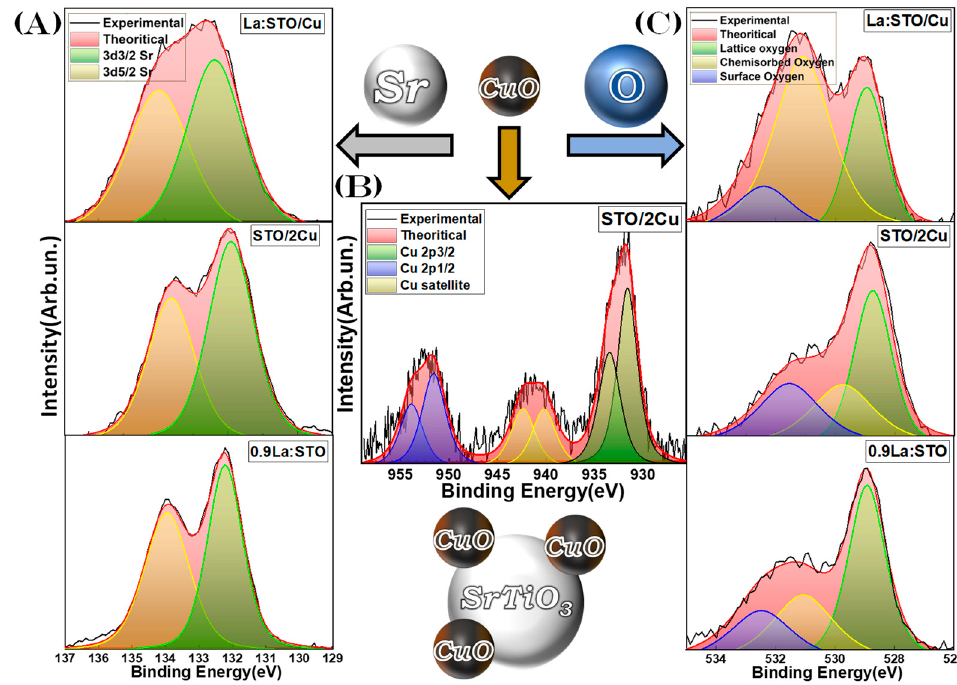
Figure 6. ( A ) Sr 3d 5/2 and Sr 3d 3/2 XPS spectra for 0.9La:STO, STO/2Cu, and La:STO/Cu materials. ( B ) Cu 2p 3/2 and Cu 2p 1/2 XPS spectra of STO/2Cu for the binding energies. ( C ) Oxygen XPS spectra of 0.9La:STO, STO/2Cu, and La:STO/Cu.